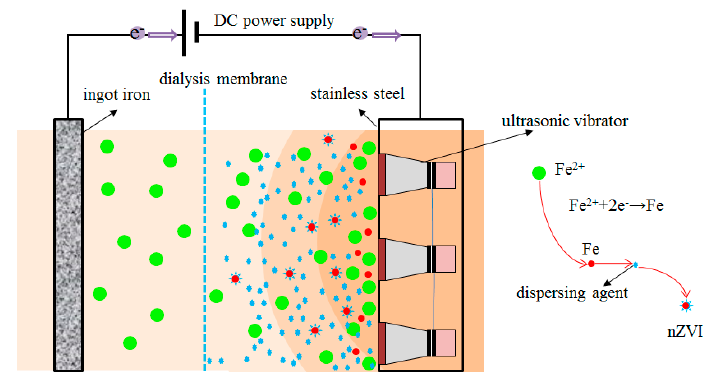
Figure 1. Electrolytic cell for preparation of nanoscale zero-valent iron (nZVI).